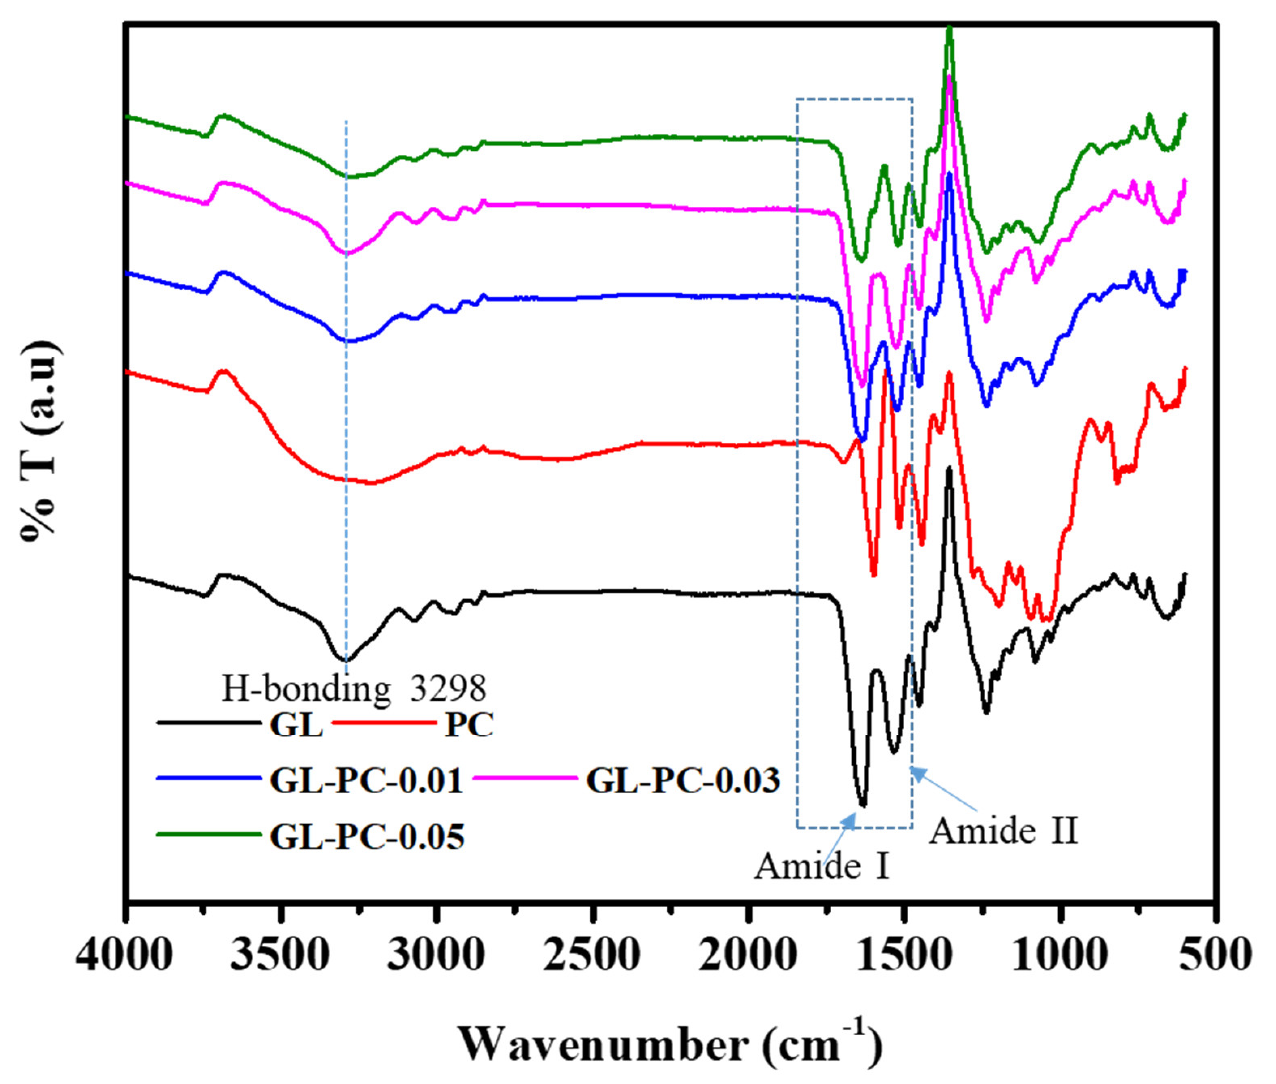
Figure 2. FTIR spectra of GL-PC hydrogels.